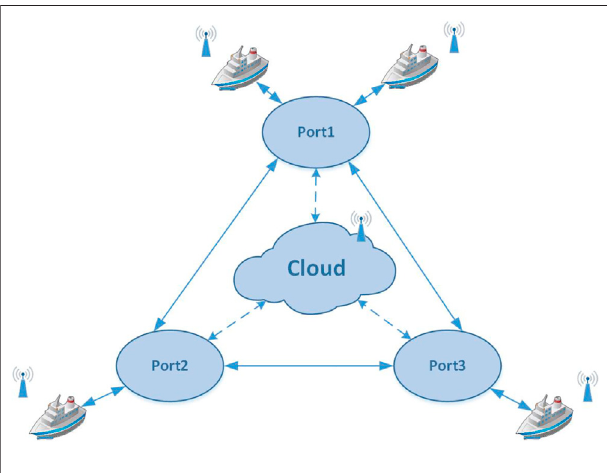
FIGURE 1 | Port-AES